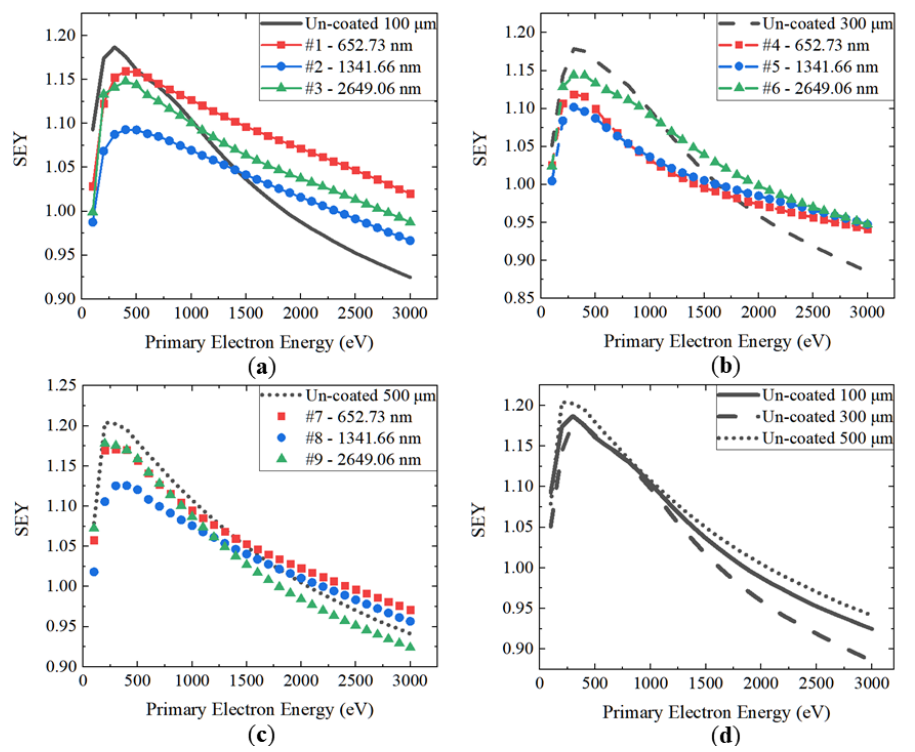
Figure 7. The SEY curves of foamed porous copper substrates with and without coating. ( a ) Uncoated foamed porous copper with 100, 300, and 500 μ m pore size. ( b ) Samples #1, #2, and #3 and uncoated 100 μ m. ( c ) Samples #4, #5, and #6 and uncoated 300 μ m pore size. ( d ) Samples #7, #8, #9, and uncoated 500 μ m. Table 3. The SEY properties of samples used in this study.